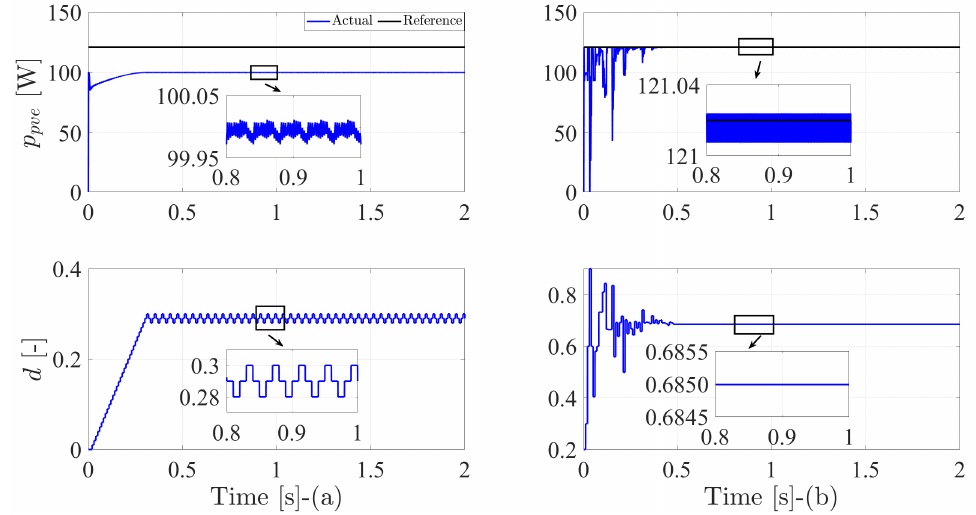
Figure 8. The performance of the MPPT methods under partial shading conditions (the global peak is on the left side): ( a ) The P&O method ( b ) The particle swarm optimization